Question: Looking at the figure, what chart type is it?
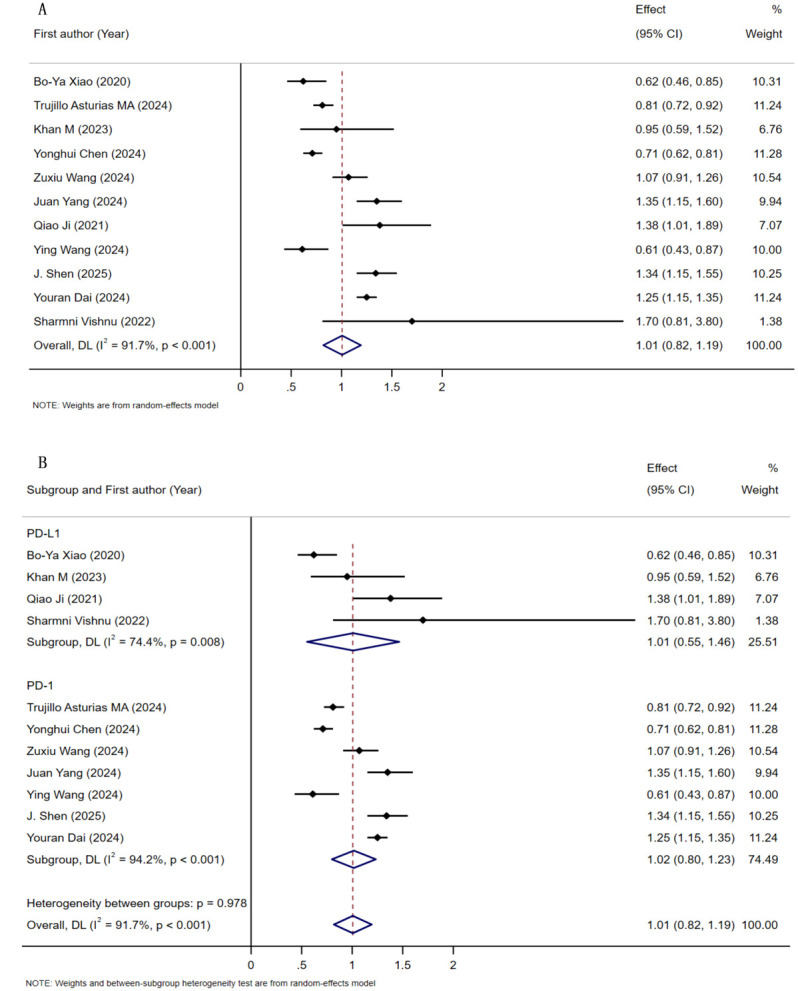
Answer: forest